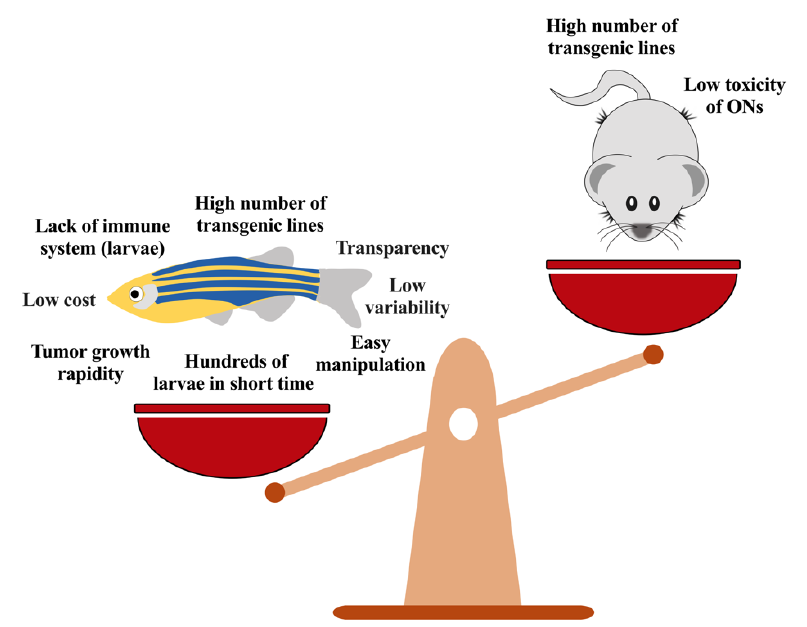
Figure 8. Zebrafish vs. mouse models. ONs: oligonucleotides.